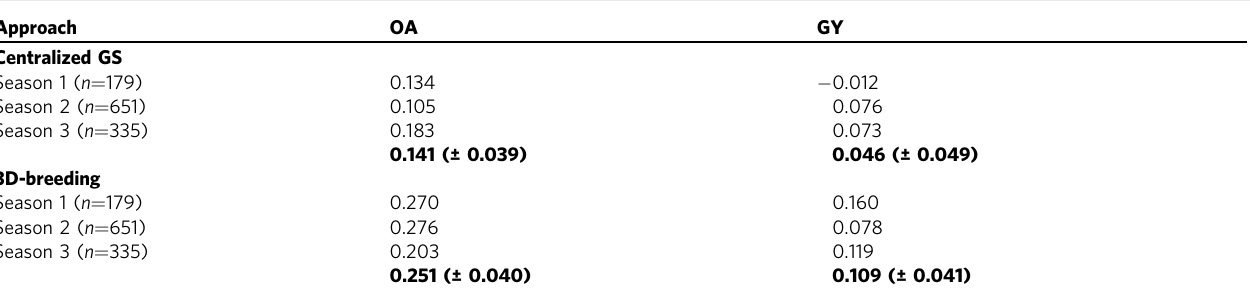
3D-breeding provides higher across-season goodness-of- fi t (Kendall τ ) than centralized genomic prediction on overall appreciation (OA) and grain yield (GY) derived from farmer rankings on decentralized fi elds. Prediction accuracy combined across seasons is given in